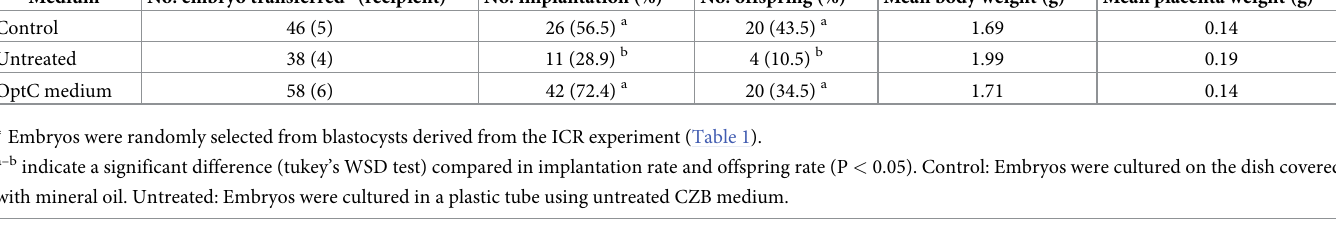
Table 5). And the offspring rate was as high as that of the conventional method even when embryos were cultured for 2 days in the thermal bottle (26.2%, Fig 3D, Table 6). We also conducted transportation experiments of embryos using a thermal bottle. A ther- mal bottle containing 2-cell embryos was transported on a round trip between Yamanashi and Ibaraki prefectures (a distance of approximately 200 km), and embryos were collected on the next day. Bottle transport without any additional protection may cause vibrations and changes in the ambient temperature inside the bottle; however, we found that the developmental rate to the blastocyst and offspring rate of both IVF and in vivo embryos was comparable with that of controls without transport (blastocyst: 96.3% and 93.3%, respectively, Table 5; offspring: 28.6% and 33.3%, respectively, Fig 3D, Table 6).